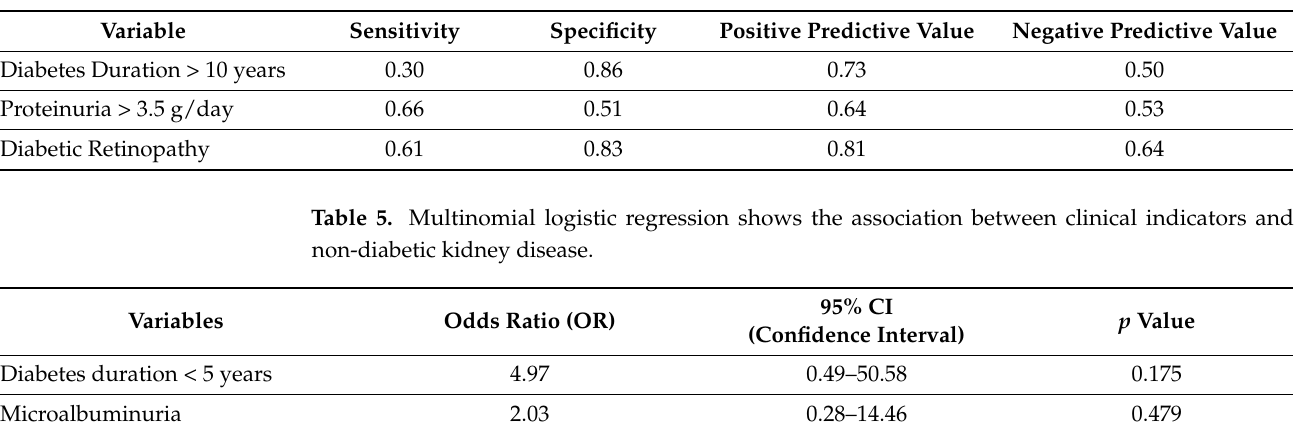
Table 4. Crosstabulation shows the association between clinical indicators and diabetic nephropathy (n = 66).